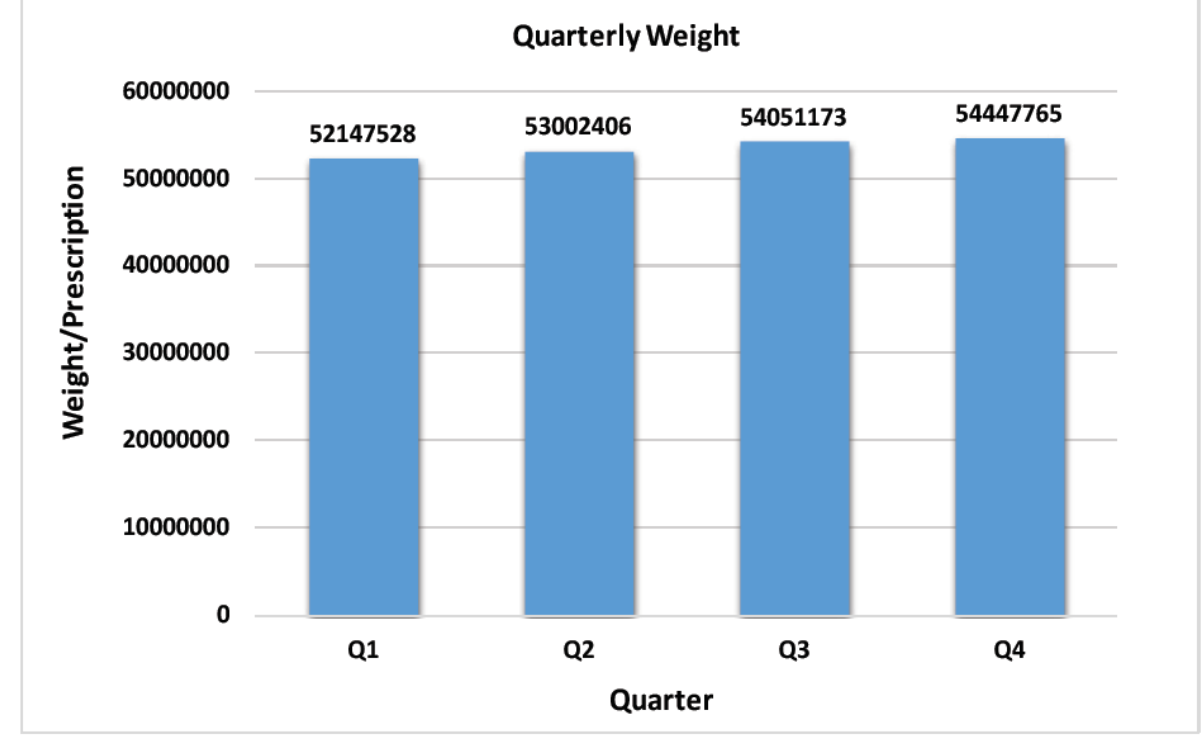
Figure 3. Projected Total Annual Number of Statin Prescriptions using Quarterly Weights